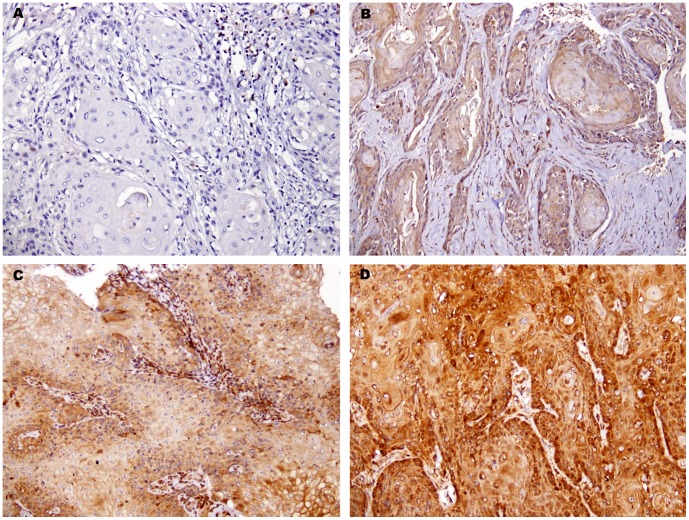
Representative immunohistochemical (IHC) staining patterns of tumor tissues for IL6 immunoreactivity in oral squamous cell carcinoma (OSCC).(A) Negative or barely conspicuous cytoplasmic staining (intensity = 0). (B) Weak cytoplasmic staining in OSCC (intensity = 1+). (C) Moderate cytoplasmic staining in OSCC (intensity = 2+). (D) Strong cytoplasmic staining in OSCC (intensity = 3+). (Immunohistochemistry: original magnification×200).